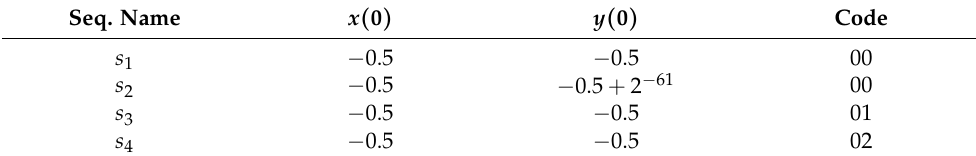
Table 1. Initial values and codes for the first four generated sequences.